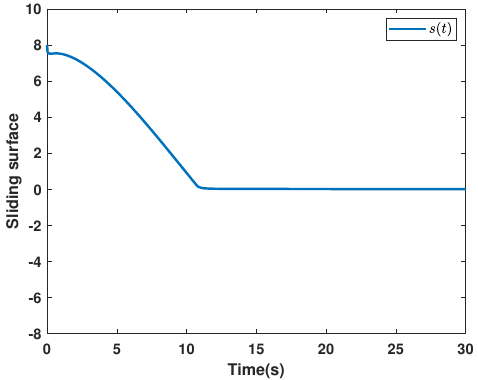
Figure 4. Surface function s ( t ) .